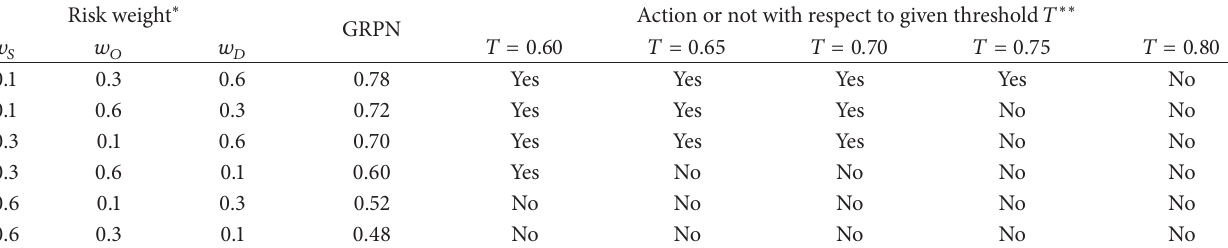
Table 4: An example of corrective action on the failure mode (FM) with respect to 𝑇 .